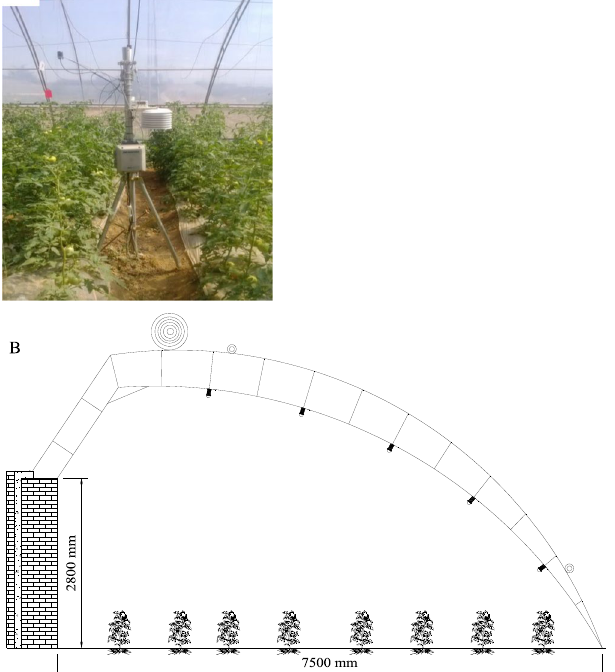
Figure 4. Photograph of the automatic weather station located in the greenhouses ( A ), and a schematic diagram of the arrangement of the greenhouse system ( B ).